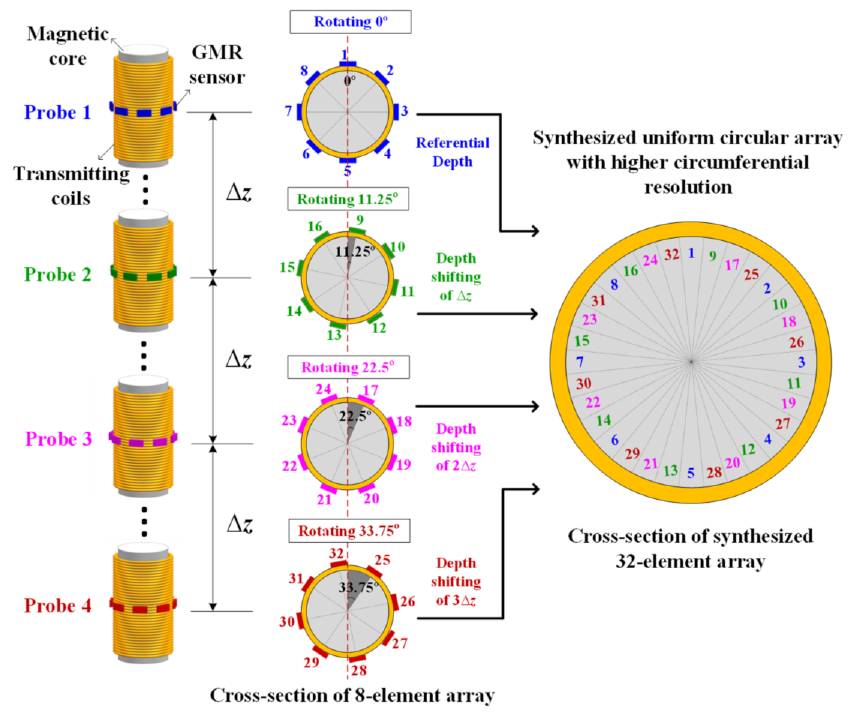
Figure 3. Structure of a synthesized uniform circular array